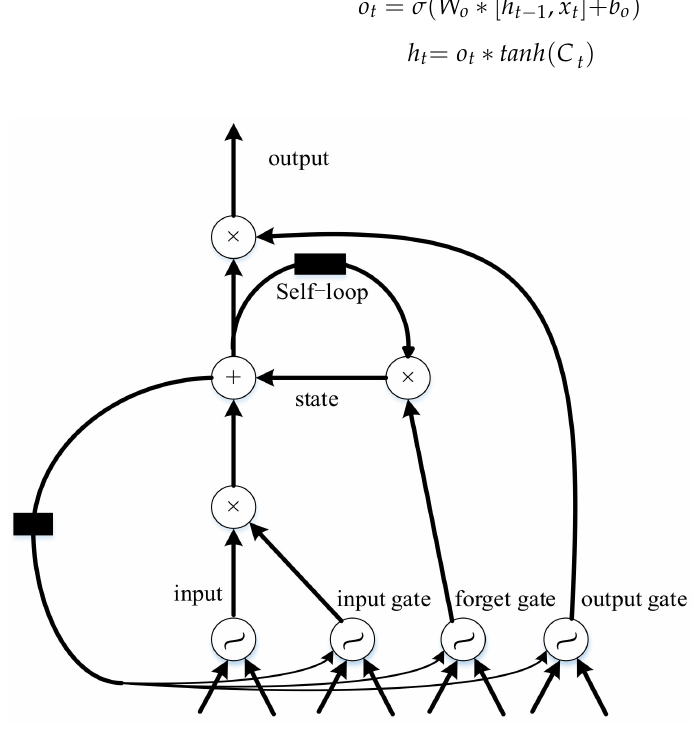
Figure 1. LSTM CELL